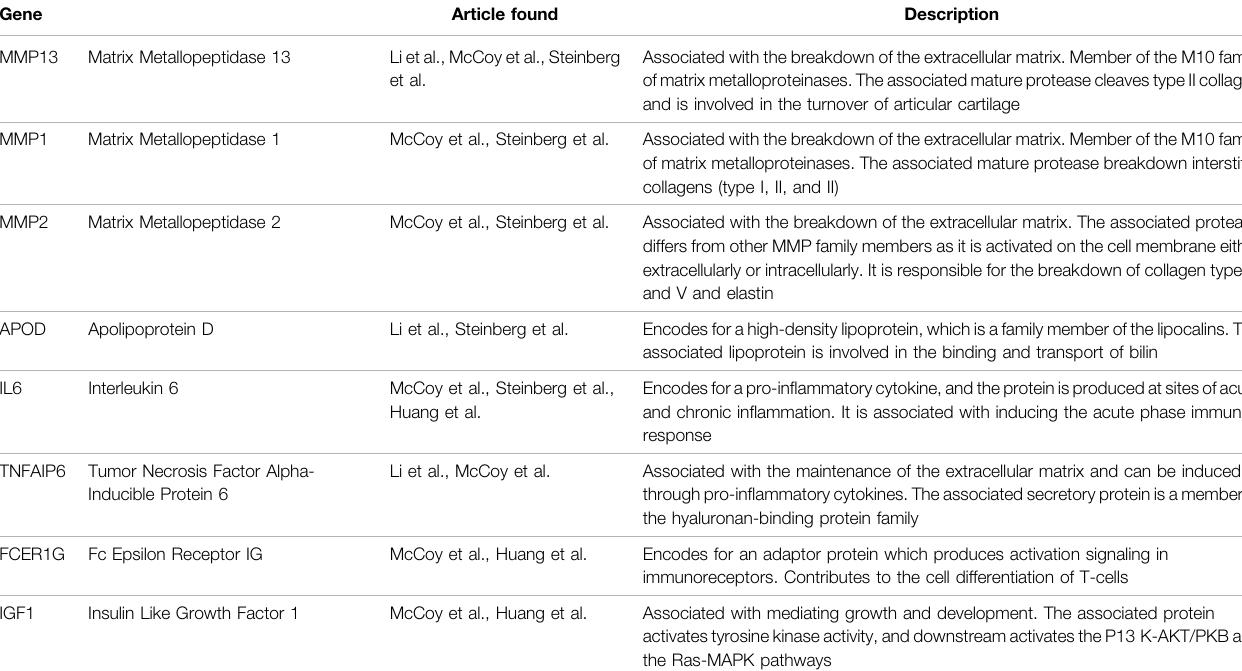
TABLE 2 | The 8 DEGs found to overlap in the 5 studies (Safran et al.,